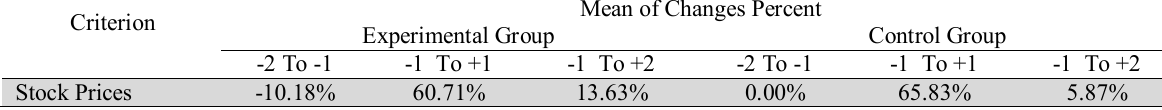
Fig. 3. The trend of net earnings changes and activity ratios in both groups Stock Prices Changes for Experimental and Control